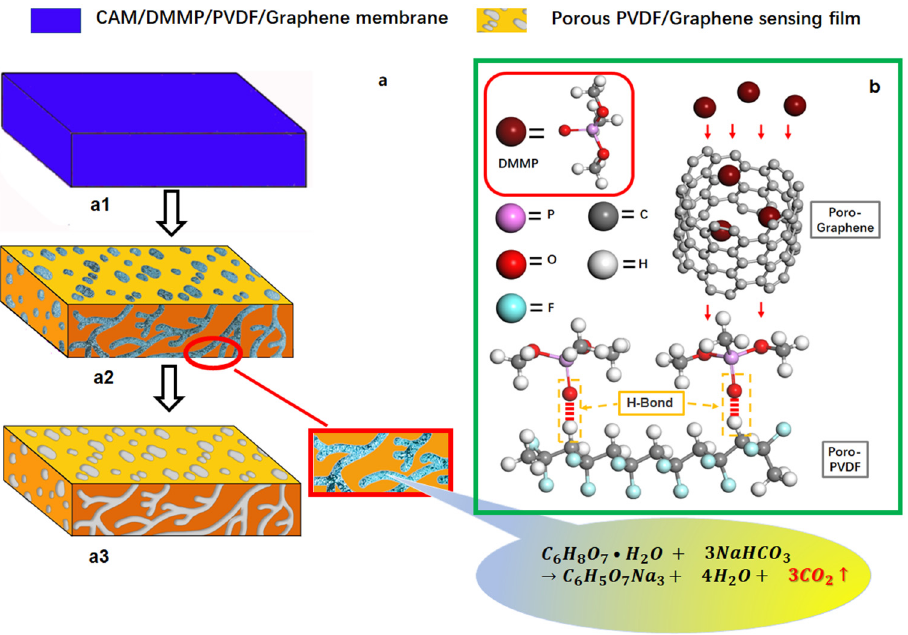
Figure 2. ( a ) Preparation process diagram of the sensing film, ( b ) gas adsorption and hydrogen bond formation diagram.